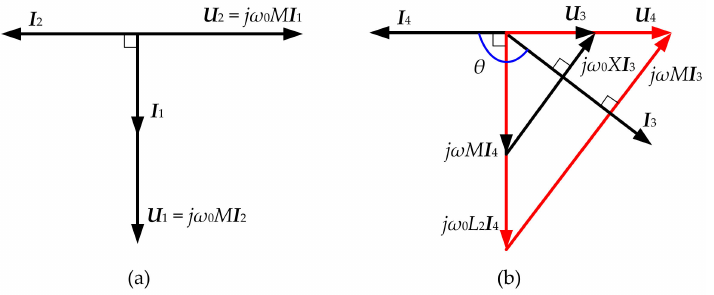
Figure 3. The phasor diagram of the currents and voltages. ( a ) SS topology; ( b ) SN